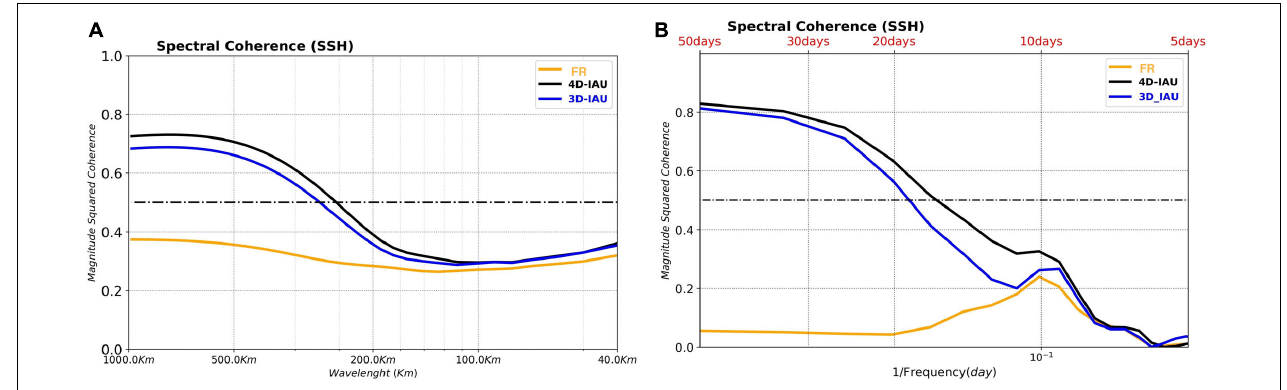
FIGURE 13 | (A) Spatial Spectral coherence between the NR SSH and the SSH from FR (orange line), 3D-IAU (blue line), and 4D-IAU (black line). The spatial domain considered is the black box on the previous figure. (B) Time Spectral coherence on the same box.